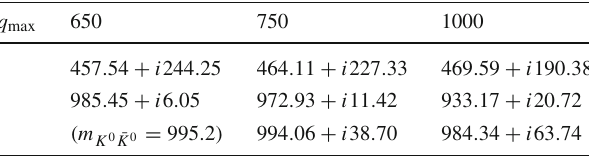
Table 2 Poles for J PC = 0 −+ PP states for the case with standard η − η (cid:4) mixing. [in